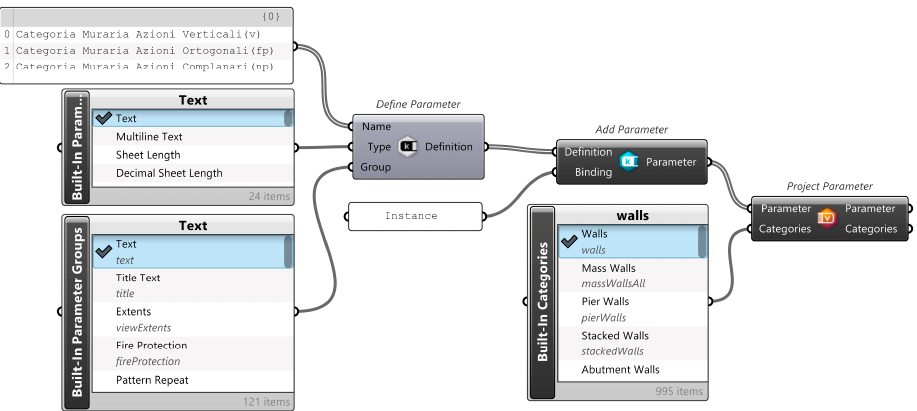
Figure 5. The VPL code which defines, in a Revit template, the properties of the IQM in the three directions of the wall plane.